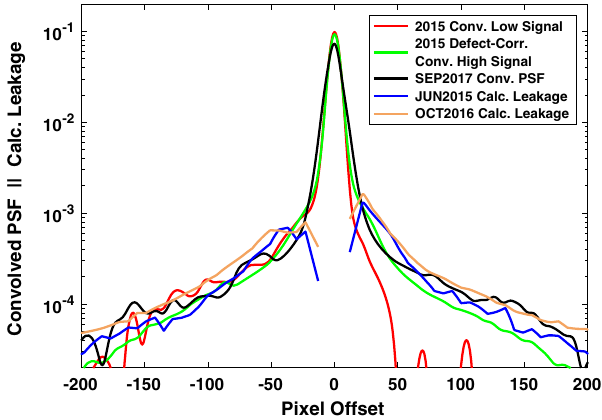
FIG. 17. Zero-order “ direct ” PSF functions after convolution with a 2.79 pixel (RMS) Gaussian plotted together with the indirectly determined PSF “ leakage ” functions in the pedestal wavelength region for the June 2015 and October 2016 exper- imental shifts.